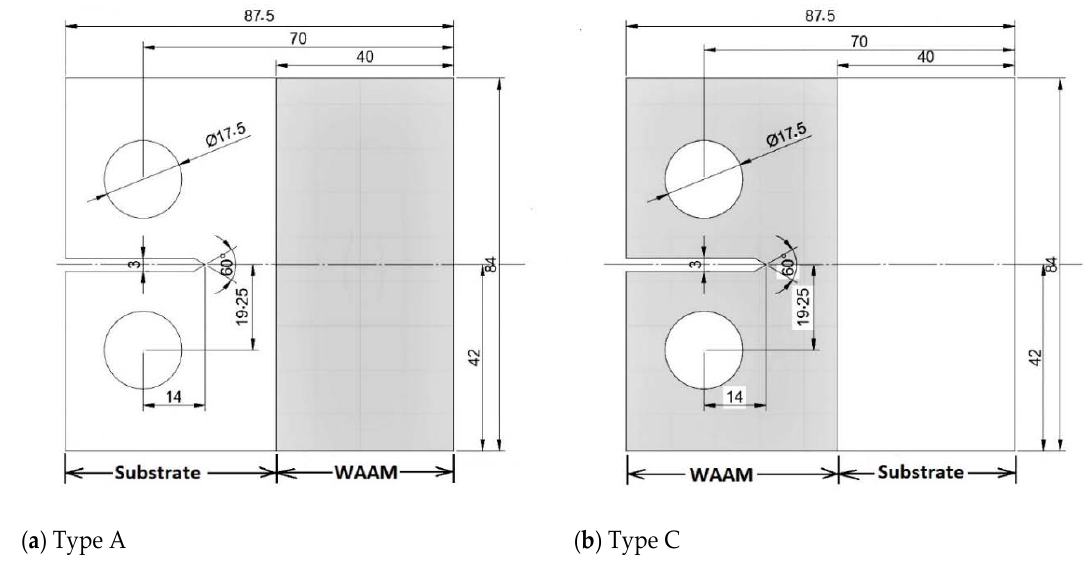
Figure 10. The specimen test geometry used in the Type A, and Type C tests; from [76].